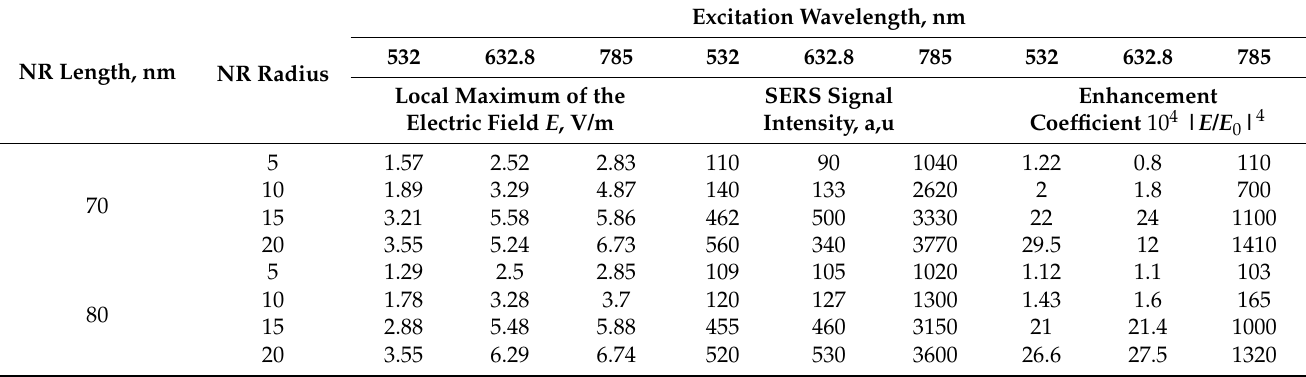
Table 2. Electric field simulation parameters for NRs without SiO 2